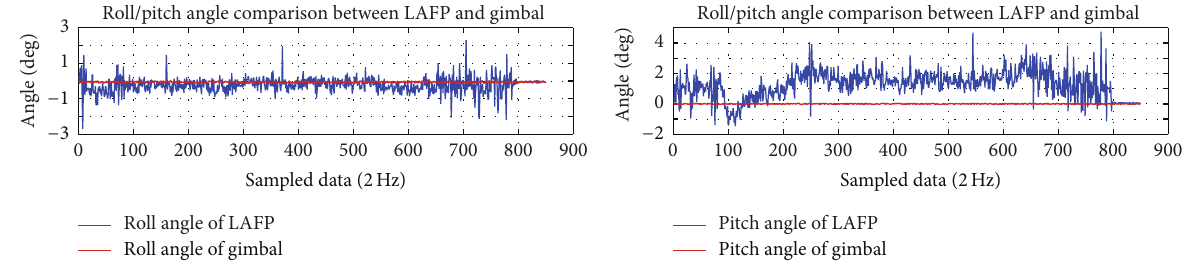
Figure 4: Gimbal roll and pitch angles referring to ULAFP attitude.